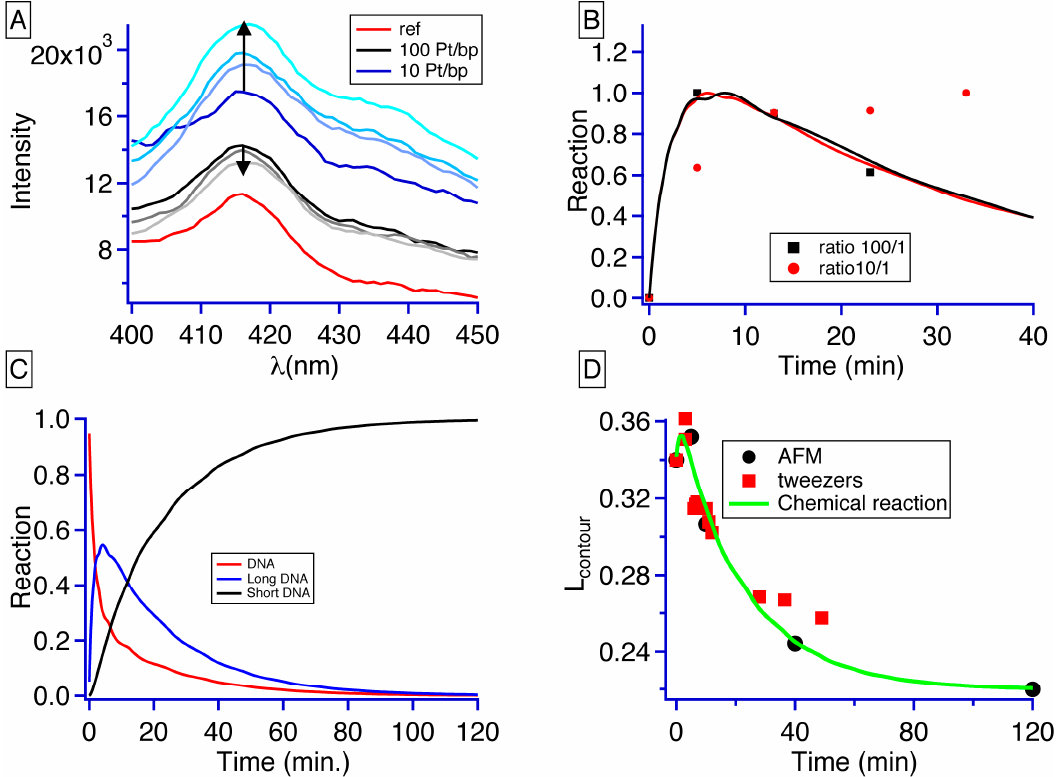
Figure 7. ( A ) Luminescence studies on the interaction between DNA and platinum. Two ratios were used in this study. The black curves represent the 100 Pt/bp ratio whereas the blue ones represent the 10 Pt / bp ratio. Time evolution is represented by the color gradient that varies from dark to light colors. The time schedule varies as follow darkest curve is 1 min of incubation, then 10, 20, and 30 min are represented. ( B ) The dots represent the evolution of the normalized maximal intensity obtained on each curve as a function of time. The lines are the normalized chemical model for the intercalation as a function of time and relative concentration. ( C ) Chemical evolution of the different species in solution as a function of time. ( D ) Evolution of the contour length as a function of time obtained with the AFM measurements (black dots), the optical tweezers (red squares) and the simulation green line.